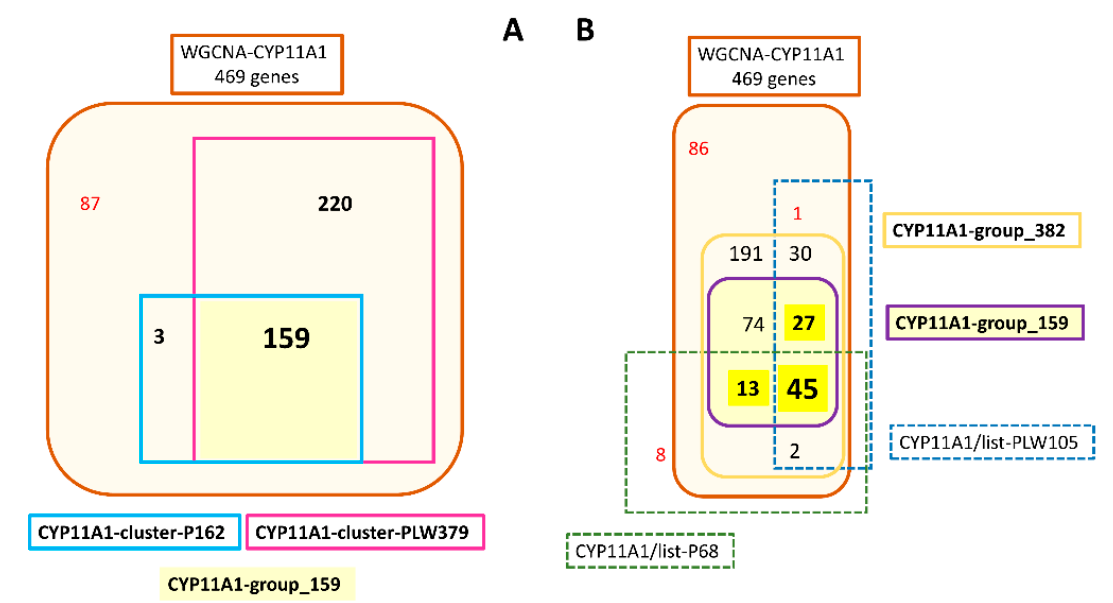
Figure 5. Analysis of genes likely to belong to CYP11A1-group. ( A ) The HCA analyses of HCAs led to defining two clusters around CYP11A1 : CYP11A1-cluster-P162 and CYP11A1-cluster-PLW379 from WGCNA-CYP11A1. The comparison of the genes’ content of CYP11A1-cluster-P162 and CYP11A1-cluster-PLW379 allowed us to define CYP11A1-group_159 and CYP11A1-group_382 including 159 and 382 genes, respectively. ( B ) The comparison of genes’ contents of CYP11A1-group_159 and CYP11A1-group_382 and the two lists of genes highly correlated to CYP11A1 (CYP11A1/list-P68 and CYP11A1/list-PLW105) led to characterizing of 45 genes constituting the core of CYP11A1-group. We suggest considering only the 45 + (13 + 27) genes as the correlation group around CYP11A1.